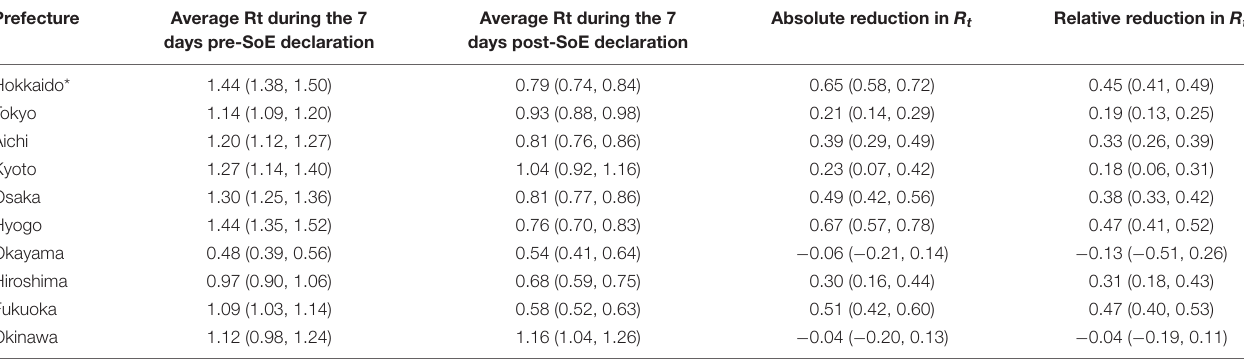
TABLE 2 | Effective reproduction number ( R t ) during the 7 days before and after declaration of a state of emergency (SoE). Prefecture Average Rt during the 7 Average Rt during the 7 Absolute reduction in R t Relative reduction in R days pre-SoE declaration days post-SoE declaration